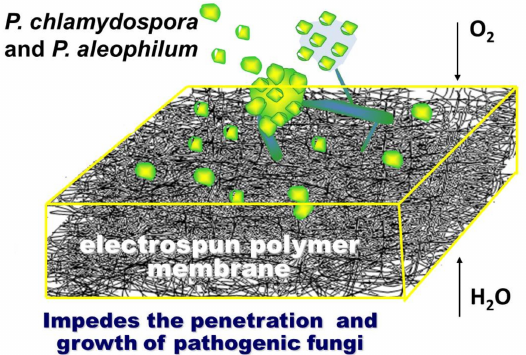
Figure 7. Schematic representation of the research